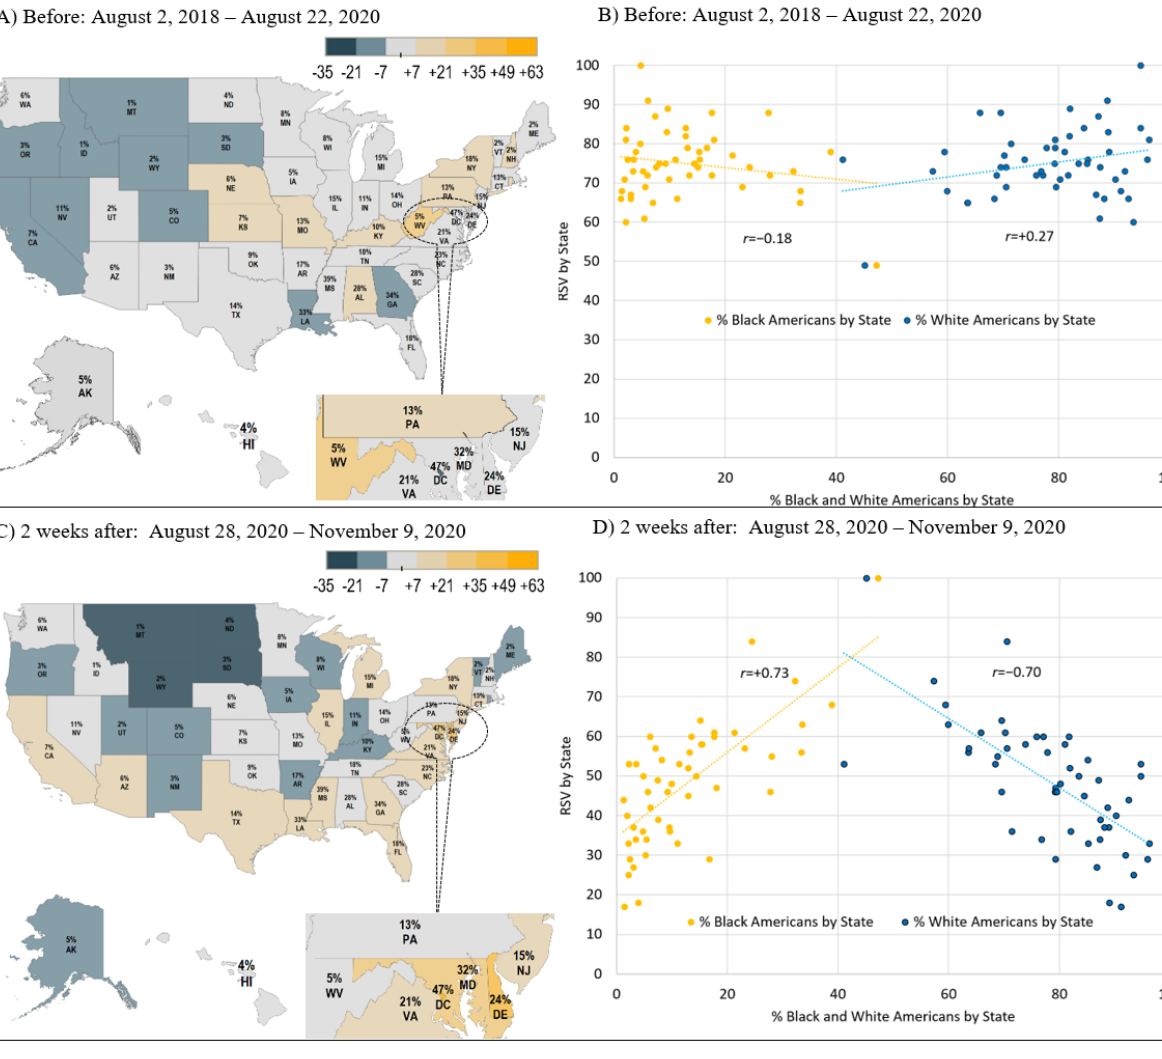
Figure 4. Shifts in demographics and Google relative search volumes for Colon Cancer by state before and after Chadwick Boseman’s death. The percentage of the Black American population by state is indicated in a smaller text on the map based on the 2019 US Census. The shading scale is based on the difference between the relative search volume value for each state and the mean relative search volume for all states during the specified